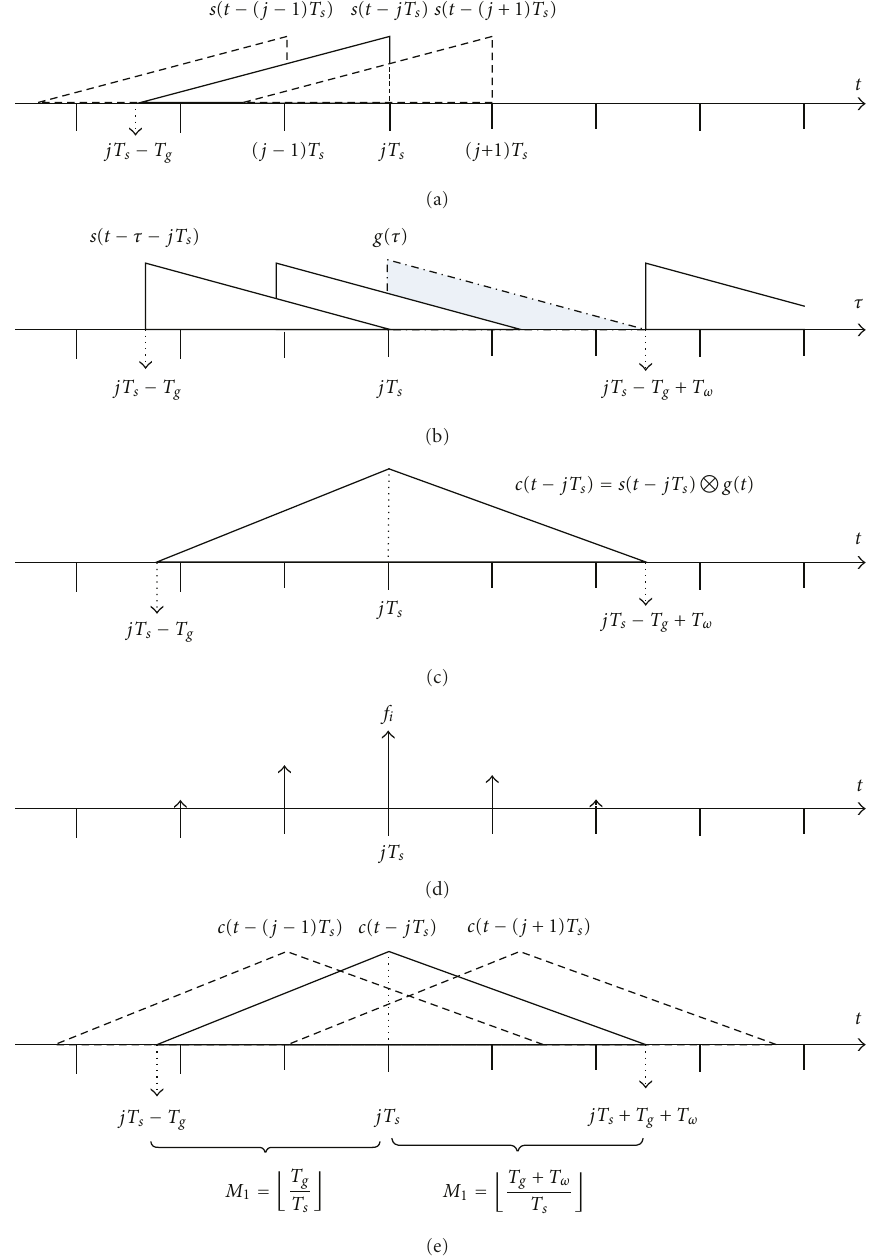
Figure 1: The process that signal transmits from the transmitter to receiver in the absence of noise. (a) Signal at the output of transmitter. (b) The process of transmitted signal convolving with CIR. (c) The received waveform for one symbol. (d) The discrete form of ECIR. (e) Received waveforms are interfered by each